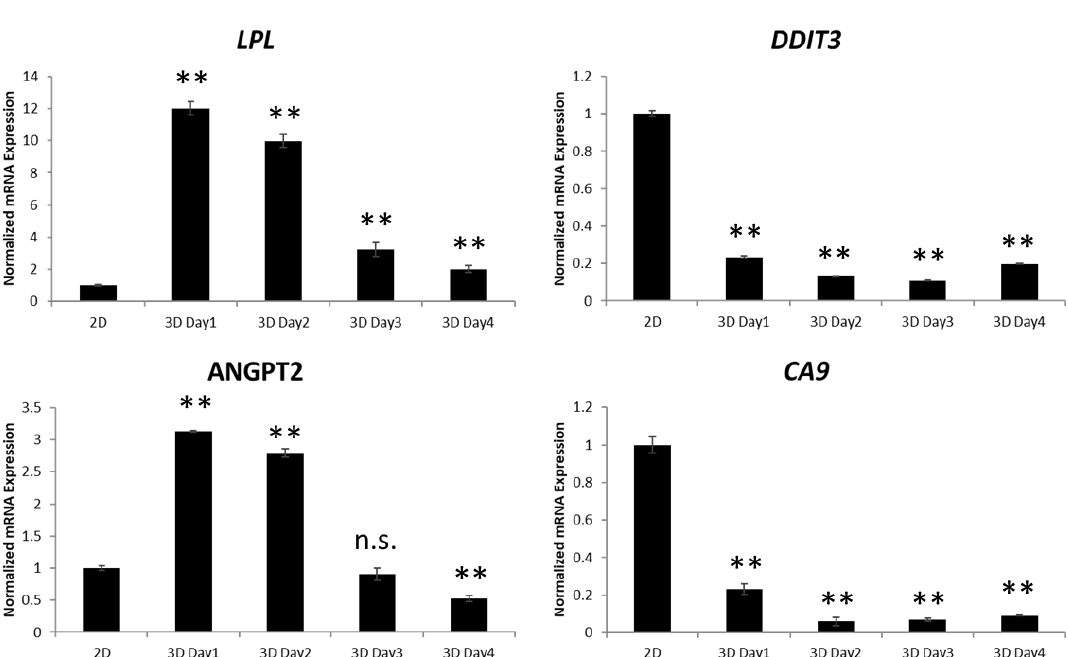
Figure 6. 3D culture changes the gene expression in MM cells. Quantitative RT-PCR of LPL , ANGPT2 , DDIT3 and CA9 mRNA levels in U266 cells in conventional culture (2D) or day 1 to 4 in 3D culture. 2.5 × 10 5 cells were seeded initially. The primers used for each gene are shown in Materials and Methods. The error bars represent standard deviation from a triplicate experiment, n.s. not significant and ** p < 0.001 compared to 2D, one- way ANOVA with Dunnett’s multiple t -test.